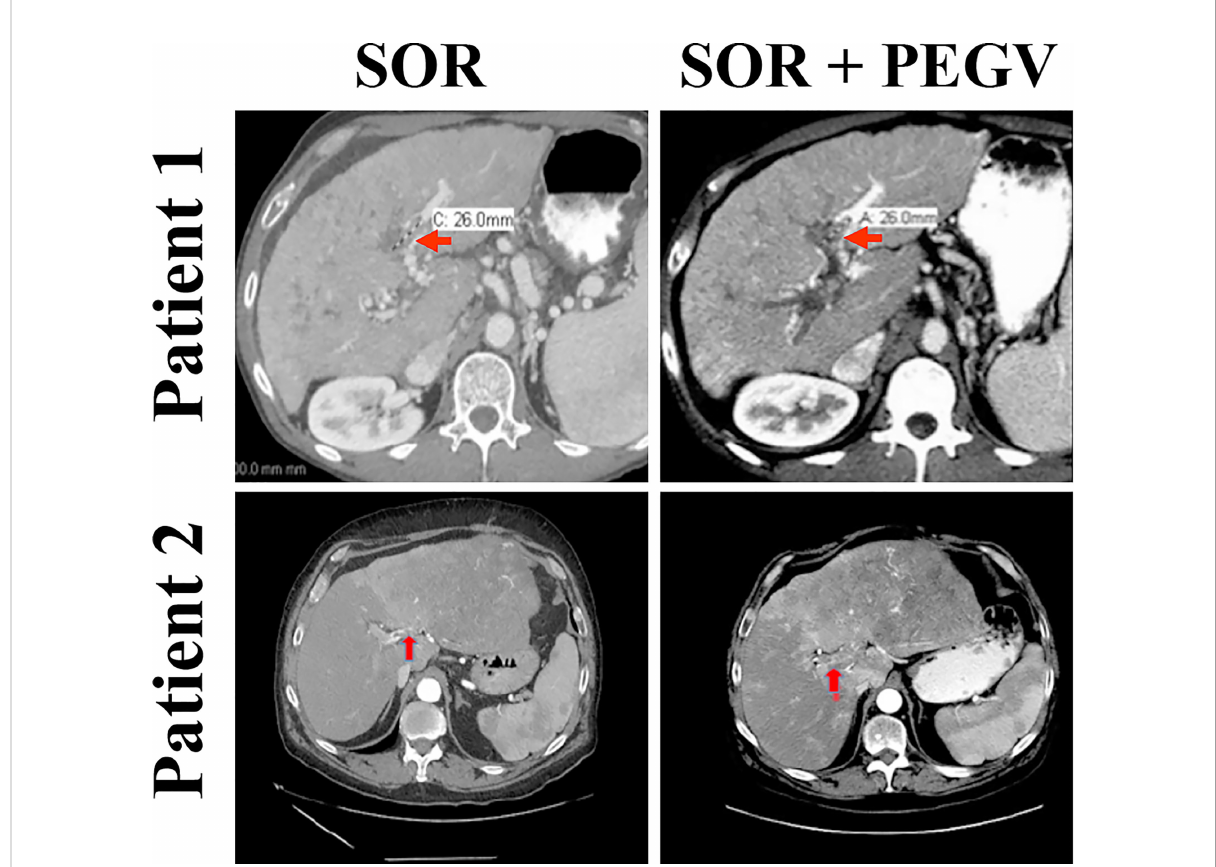
FIGURE 7 Blockade of GH/GHR signaling by pegvisomant causes tumor stability in HCC patients who develop sorafenib resistance. Two HCC male patients with clinical resistance and progression on sorafenib as well as with serum GH levels (5.3 and 3.7 µg/L) above those mandated by the FDA to allow administration of pegvisomant (normal level in males is ≤ 0.97 µg/L) were given pegvisomant, in addition to sorafenib, at a dose of 10 mg/kg/day subcutaneously. MRI scans after the addition of pegvisomant show disease stability. Patient 1 had a biomarker response in the form of a 40% decrease in AFP after combining pegvisomant with sorafenib. Patient 2 had low AFP (<20 µg/L) at baseline, which remained low on dual